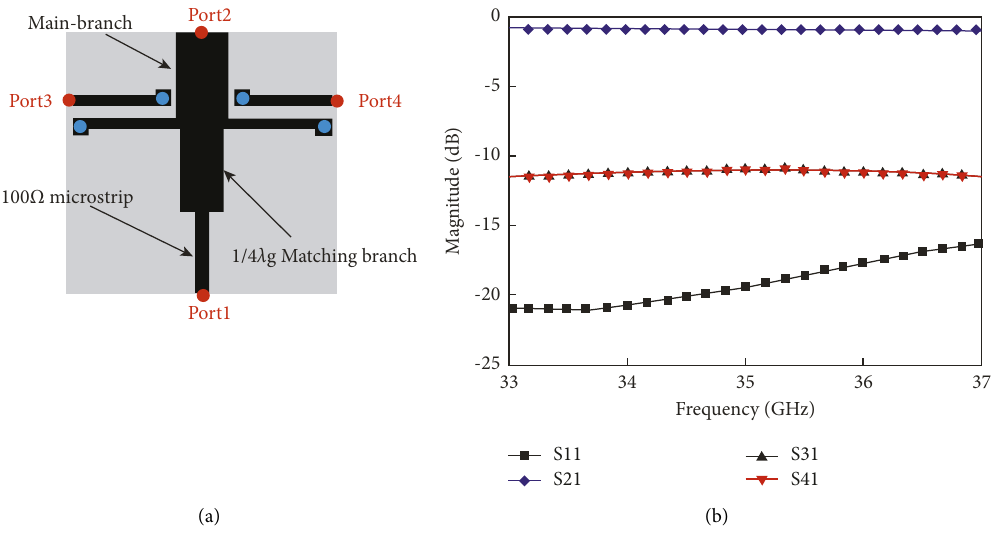
Figure 4: (a) Configuration of divider with division ratio of 12 :1:1. (b) Simulation